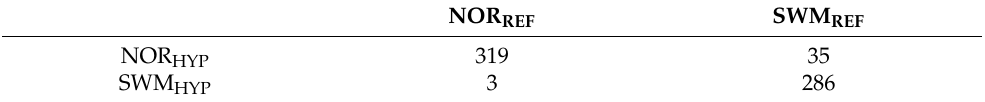
Table 3. Monitored activities’ confusion matrix for DNN acoustic models with 4 hidden layers. NOR REF SWM REF NOR HYP 319 35 SWM HYP 3 286